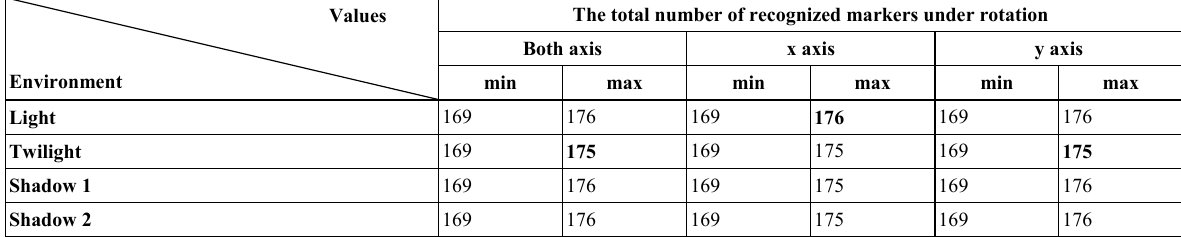
Values The total number of recognized markers under rotation